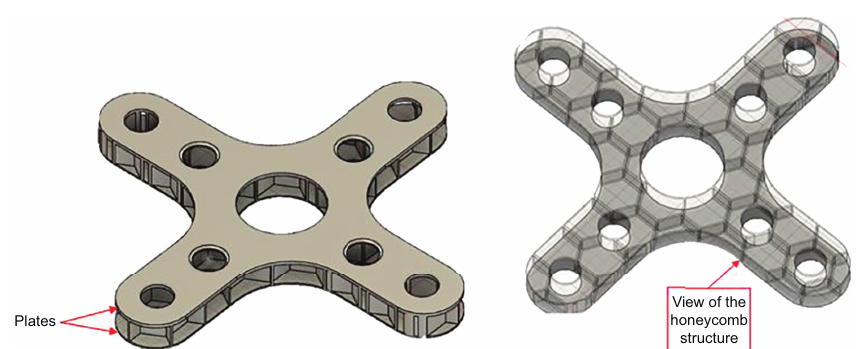
Figure 3. Dimensions of the holder